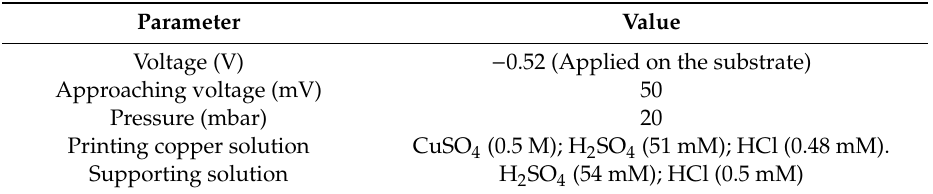
Table 2. The parameters selected in the experimental